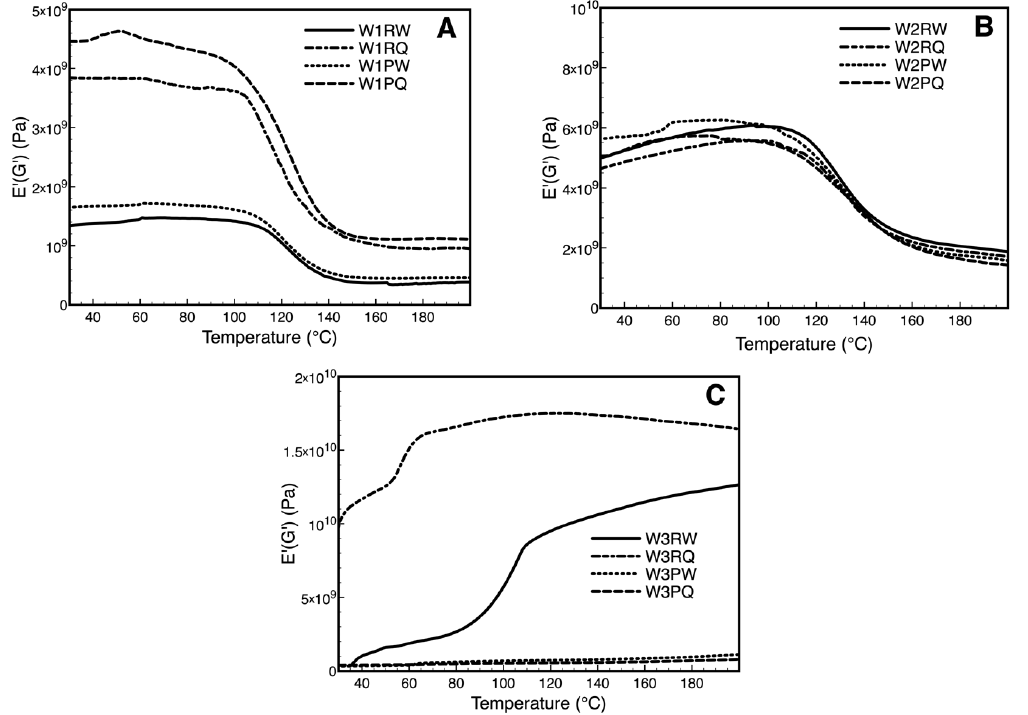
Figure 5. Temperature dependence at 4 Hz of storage (E ’ ) modulus of W1 ( A ), W2 ( B ), W3 ( C )